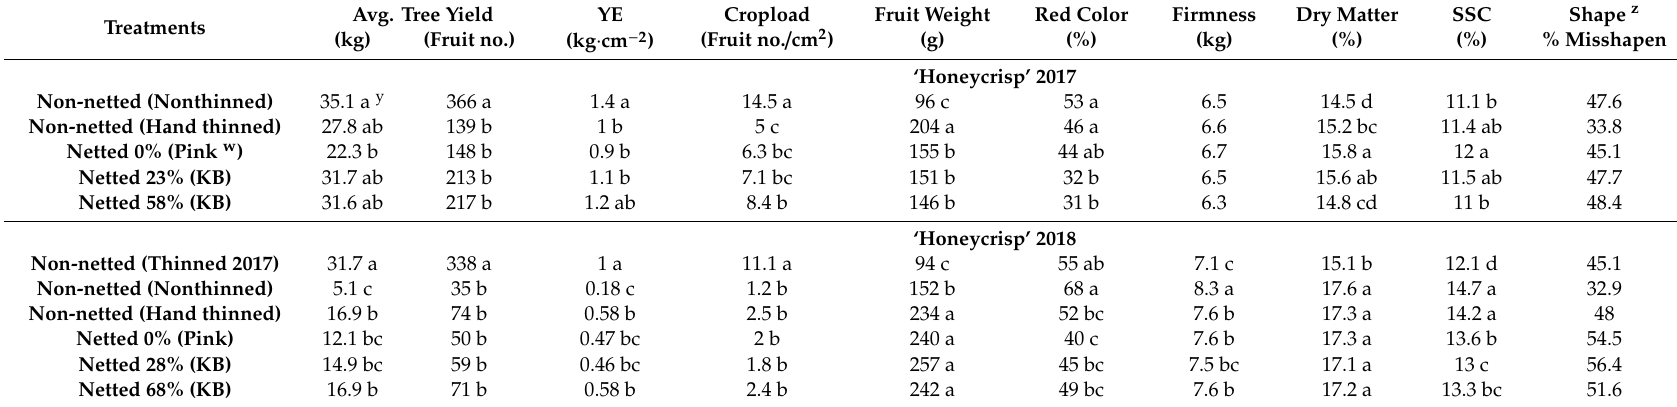
z Shape was expressed as percentage of fruit asymmetrical in both horizontal and vertical plane. y Mean separation among treatments by Tukey HSD ( p < 0.05), whereby means associated with di ff erent letters are significantly di ff erent. w Pink, pink stage of bud development; KB, king flower bloom. y Data are means of four replicates. Mean separation among treatments by Tukey HSD ( p < 0.05), whereby means associated with di ff erent letters are significantly di ff erent. n = 4 for yield, YE, crop load, and avg. fruit wt.; n = 24 and 40 for individual fruit quality attributes for 2017 and 2018,